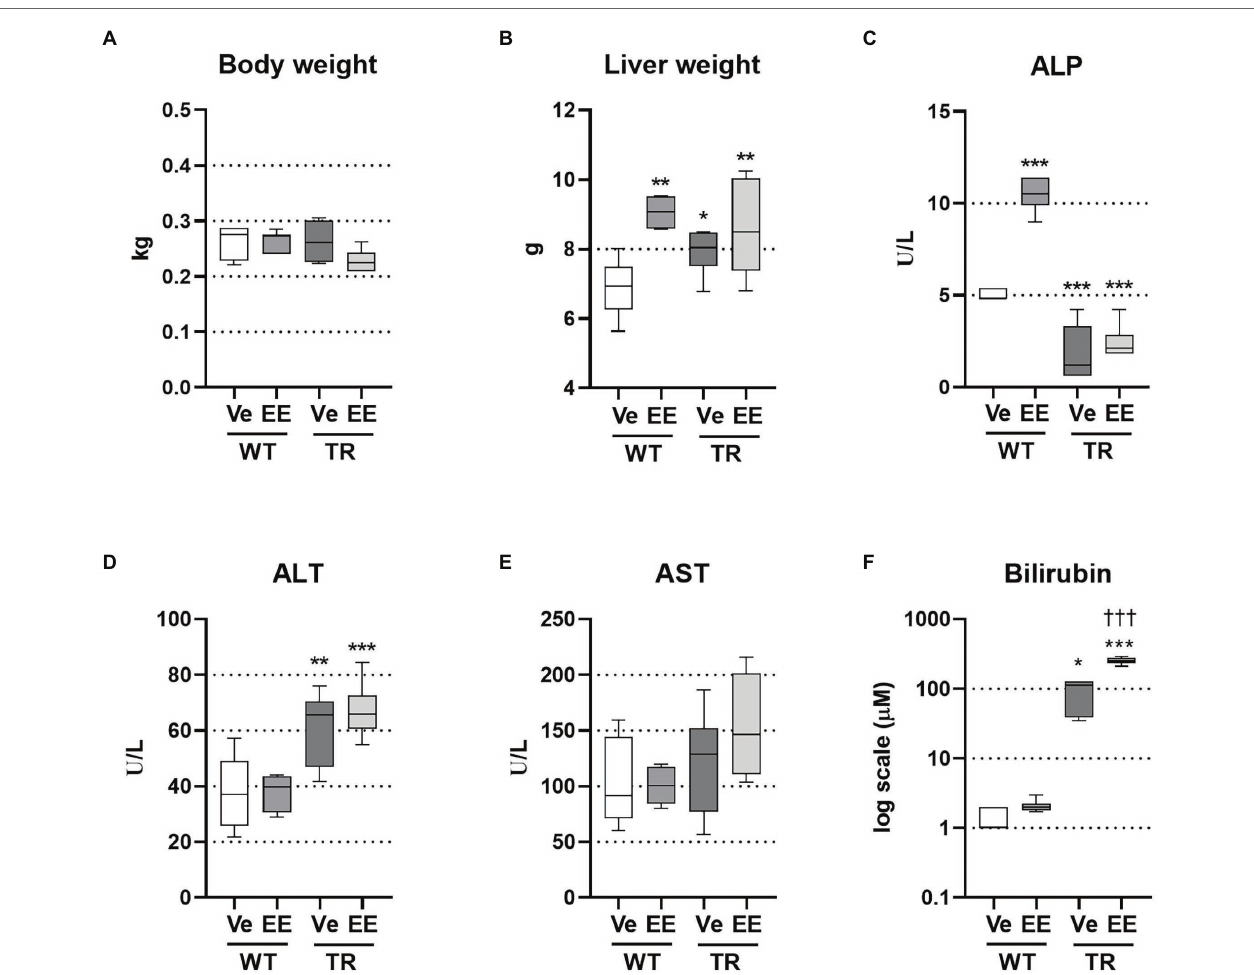
FIGURE 1 | Ethinylestradiol (EE)-induced cholestasis exacerbates hyperbilirubinemia in multidrug resistance-associated protein 2 (Mrp2)-deficient TR rats. Cholestasis was induced by EE administration (5 mg/kg, s.c.) over 5 consecutive days. Experimental groups: WT-Ve, WT rats receiving vehicle; WT-EE, WT rats receiving ethinylestradiol; TR-Ve, TR rats receiving vehicle; and TR-EE, TR rats receiving ethinylestradiol. (A) Body weight at the end of the experiment. (B) Liver weight. (C) Plasma alkaline phosphatase (ALP) activity. (D) Plasma alanine aminotransferase (ALT) activity. (E) Plasma aspartate aminotransferase (AST) activity. (F) Plasma bilirubin concentrations. Data are presented as medians, with boxes and whiskers representing the interquartile range and 5th-95th percentiles, respectively. Significance: * p < 0.01, **p < 0.01, *** p < 0.001 compared to vehicle-treated wild-type (WT) rats; ††† p < 0.001 compared to vehicle- treated TR